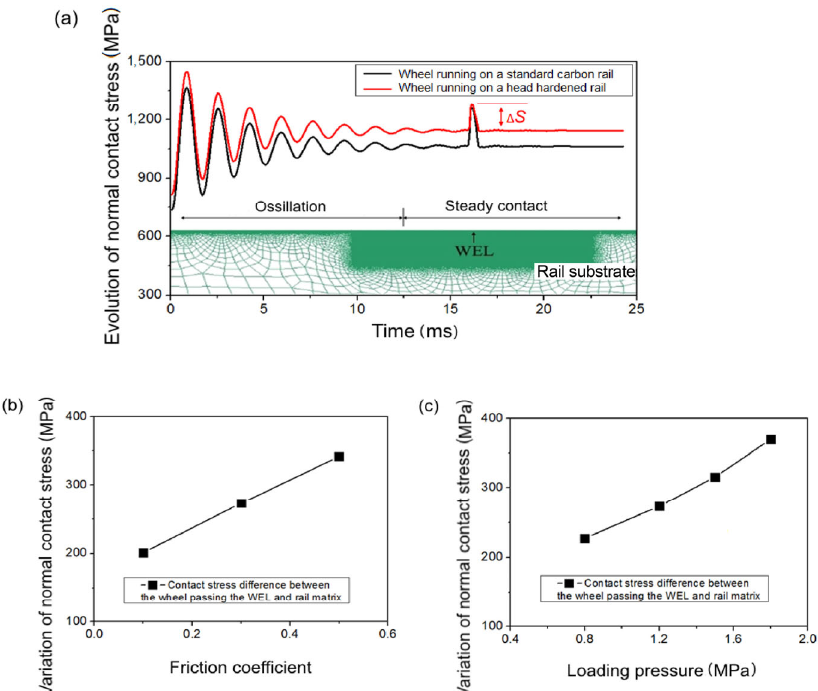
Fig. 3 (a) Normal contact stress evolution history during wheel-rail contact for both SC rail and HH rail under the loading pressure of 1.2 GPa, μ of 0.3, a / b = 5, and Sr of 0.5%; (b) influence of μ on variation of normal contact stress; (c) influence of loading pressure on variation of normal contact